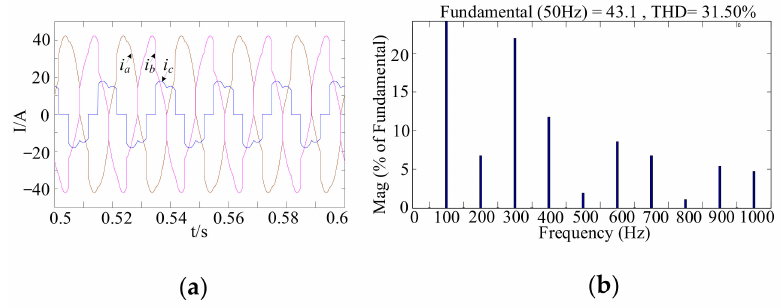
Figure 17. Uncompensated waveforms: ( a ) current of power grid; ( b ) THD of B-phase current.